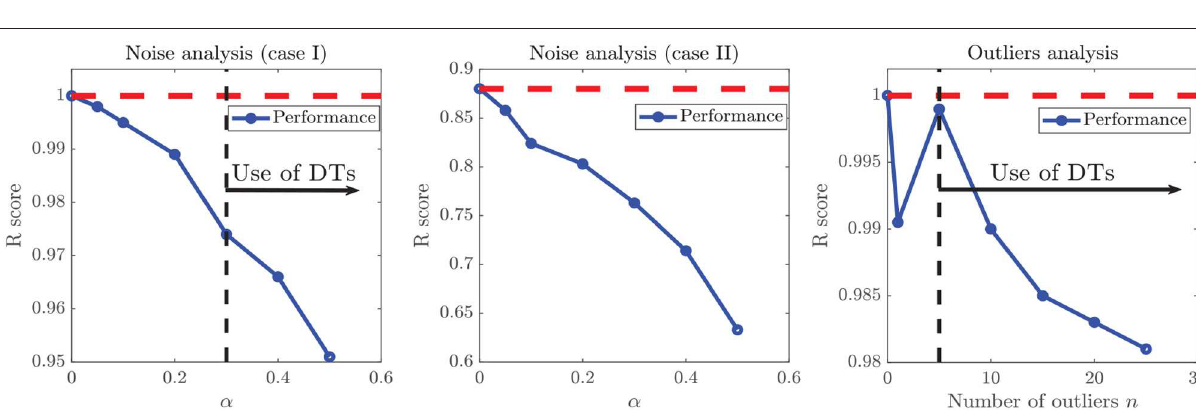
FIGURE 8 | Evolution of model performance metrics against noise. (Left) Model performance on a linear ground truth function with white noise. (Center) Model performance on experimental data (Case Study III) with white noise. (Right) Model performance on a linear ground truth function with different number of outliers. In artificial datasets with linear ground truth functions (left and right images) x user was set equal to 0.95 to force the algorithm to continue further in the proposed methodology. When the linear model performance fell under the selected threshold, the algorithm swap to DT models, which rose the performance metrics again, generating a break in the sloping